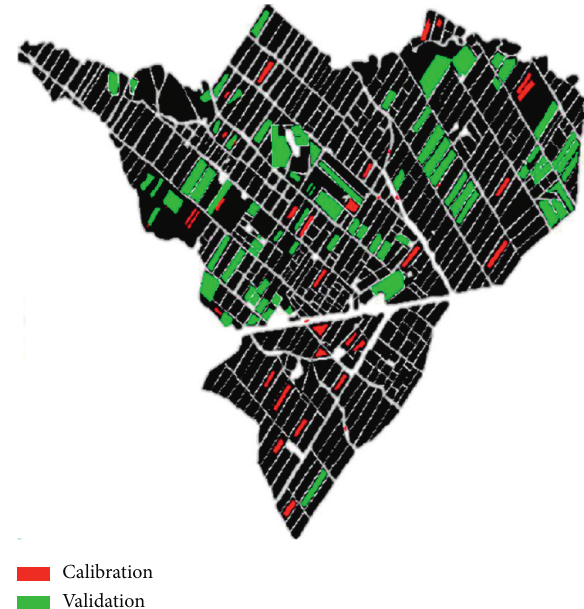
Figure 3: Spatial distribution of reference data over R3